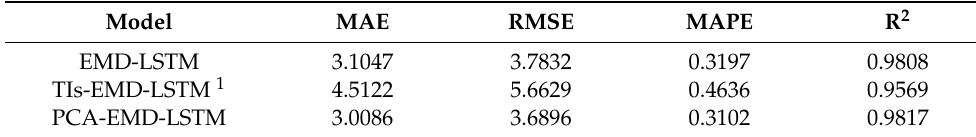
Table 8. Results of EMD-LSTM with additional input features.